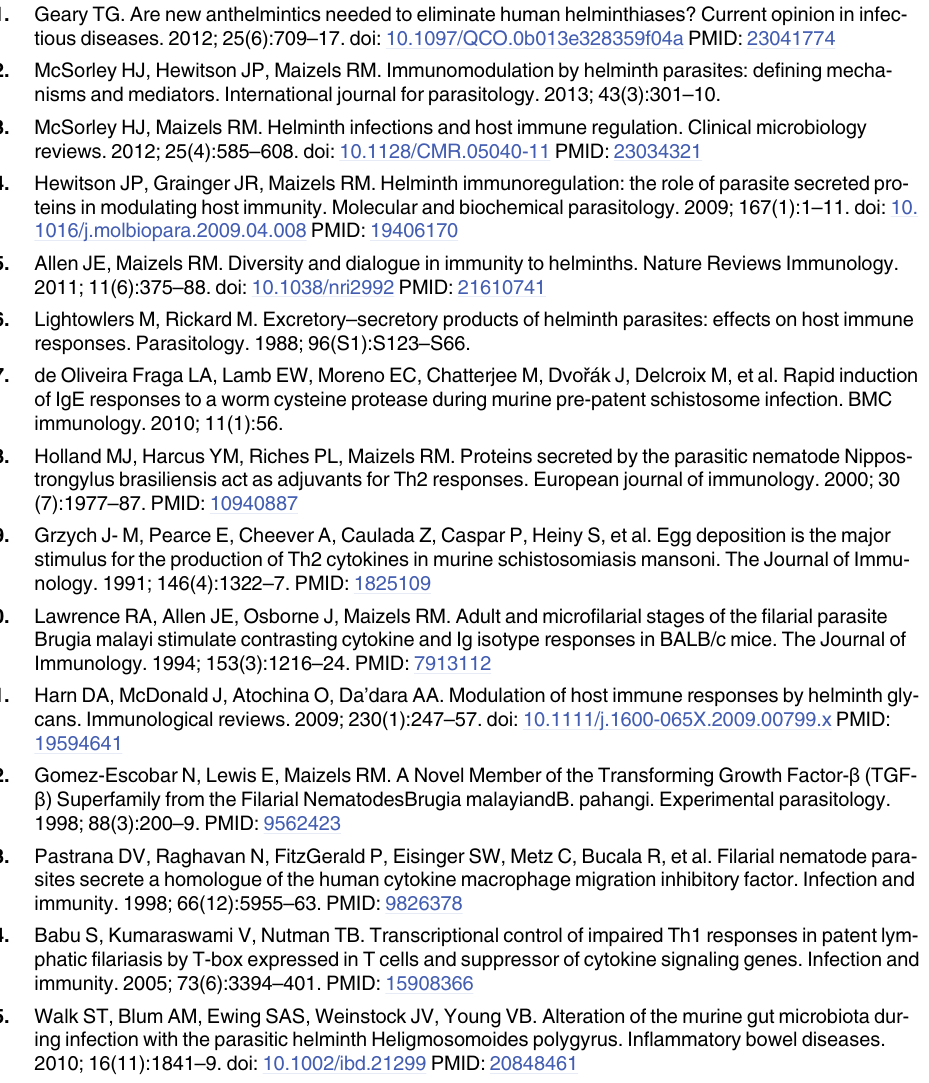
S5 Fig. Scatter plot showing expression values of two genes after batch effect correction. The symbols are shaped according to their experimental conditions with colors based on their dataset memberships.